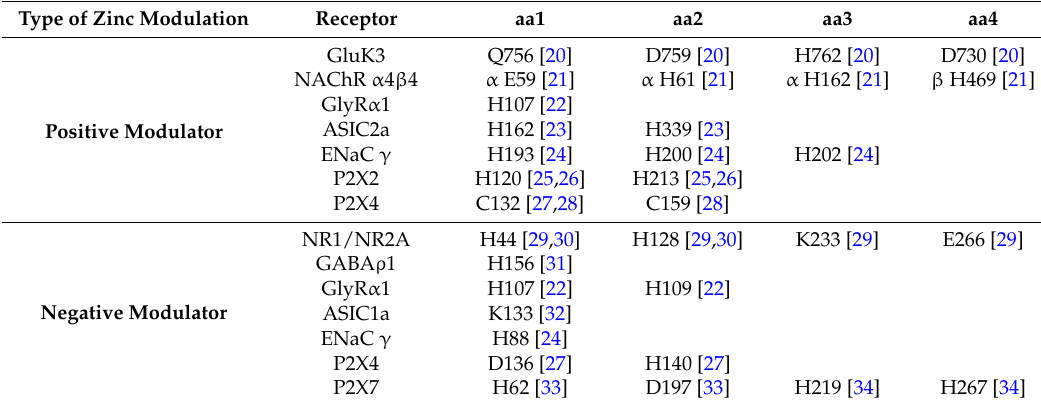
Table 1. Zinc ligands in ionotropic receptors.